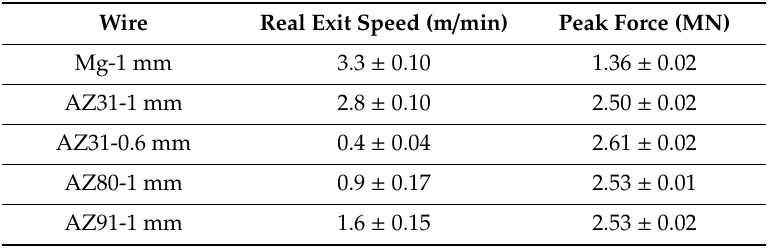
Table 2. Extrusion peak force and exit speed of the